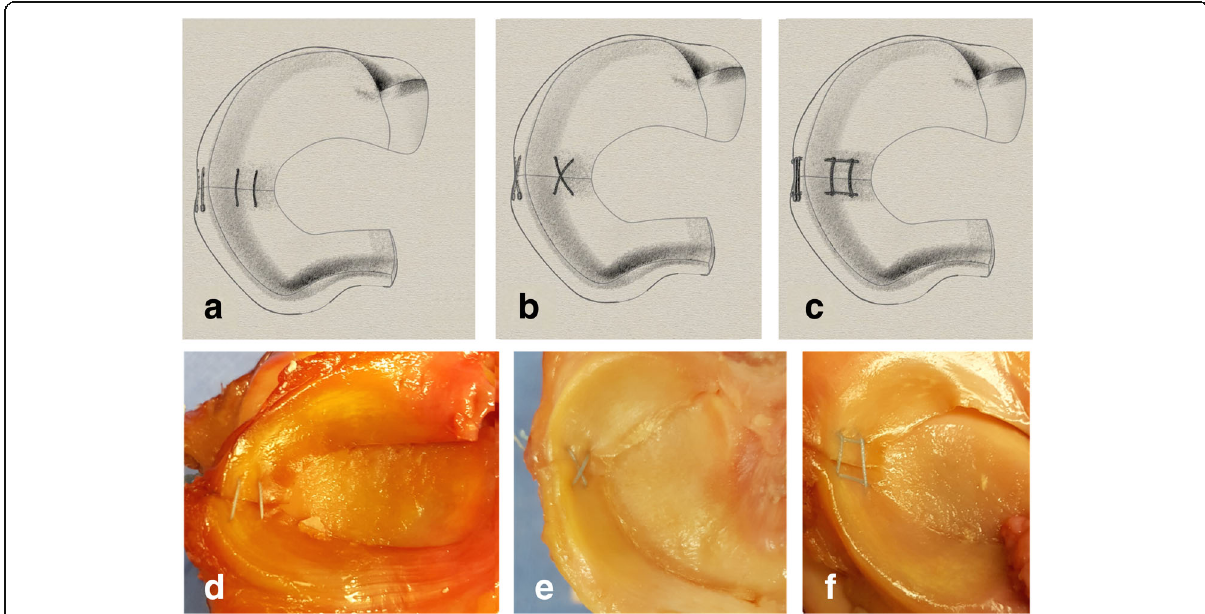
Fig. 1 a Standard Repair with 2 parallel sutures across the radial tear. b . Cross Stitch Repair with 2 perpendicular sutures in a “ X ” configuration. c . Rebar Repair with 4 sutures, 2 longitudinal reinforcing sutures on each side of the tear with 2 horizontal stitches across the reinforcing sutures and the tear. d , e , f are cadaver views of the parallel suture repair, cross stitch repair and Rebar Repair respectively